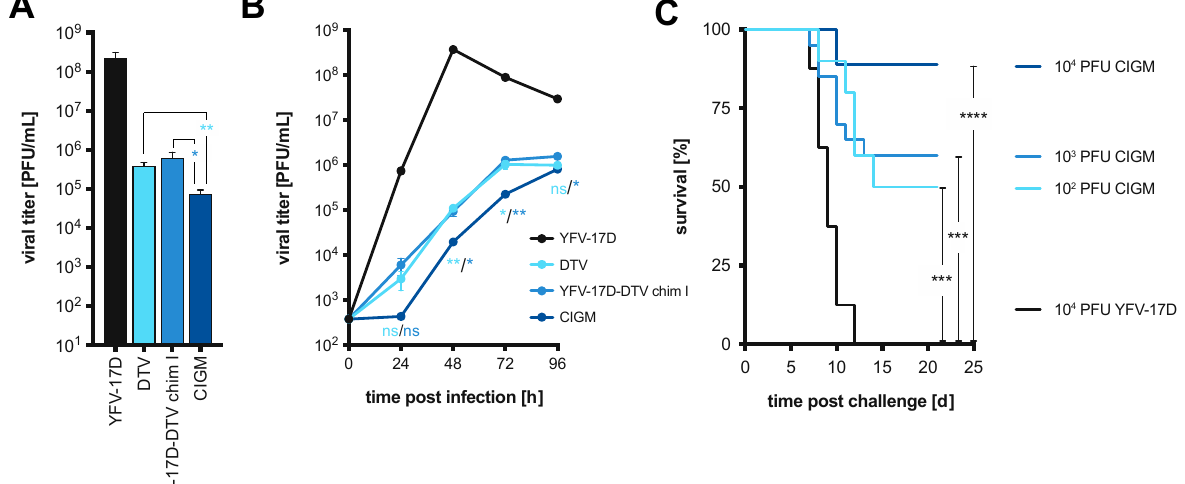
Figure 4. In vitro and in vivo replication kinetics of Chimera I harboring an NS1 glycosylation site mutation. ( A , B ) Huh-7.5 cells were infected with YFV-17D, DTV, Chimera I, or Chimera I harboring an NS1 glycosylation site mutation (CIGM), using ( A ) MOI = 1 PFU/cell or ( B ) MOI = 0.01 PFU/cell. Supernatants were harvested at the indicated times and the infectious virus was titered by plaque assay. Statistical signi fi cance was determined by Students t -test. Light blue, CIGM versus the parental WT DTV; blue, CIGM versus Chimera I. ns, not signi fi cant; *, p < 0.05, **, p < 0.01. ( C ) Survival curves of BL6 mice vaccinated with 10 2 PFU ( n = 10), 10 3 PFU ( n = 20), and 10 4 PFU ( n = 9) CIGM followed by a lethal DTV challenge at 28 days post-vaccination. YFV-17D was used as a control vaccine at 10 4 PFU ( n = 8). Statistical signi fi cance was determined by the Log-rank (Mantel-Cox) test. ns, not signi fi cant; *, p < 0.05; **, p < 0.01; ***, p <0.001; ****, p < 0.0001.